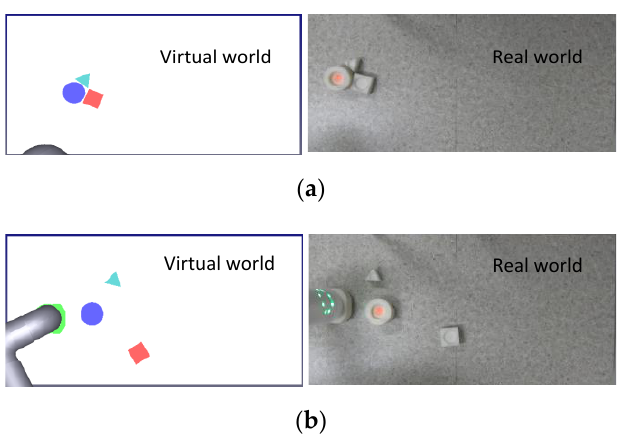
Figure 13. Scattering experiments with three objects by considering circular shapes only: ( a ) before collision; ( b ) after collision. Manipulator velocity: 0.5 m/s.